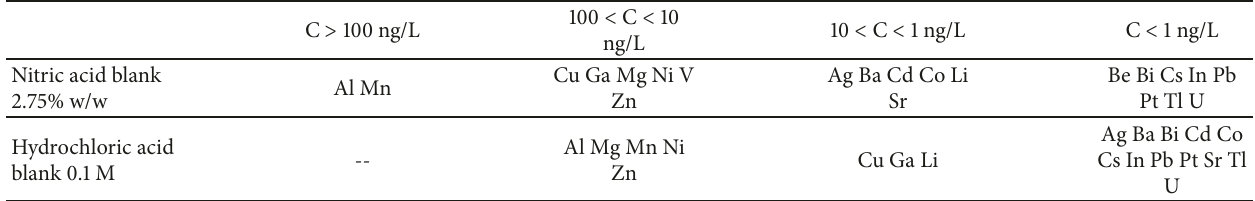
Table 1: Elemental concentrations (C) in blank solutions under optimized conditions (subboiling temperature 82 ∘ C, one distillation cycle). C > 100